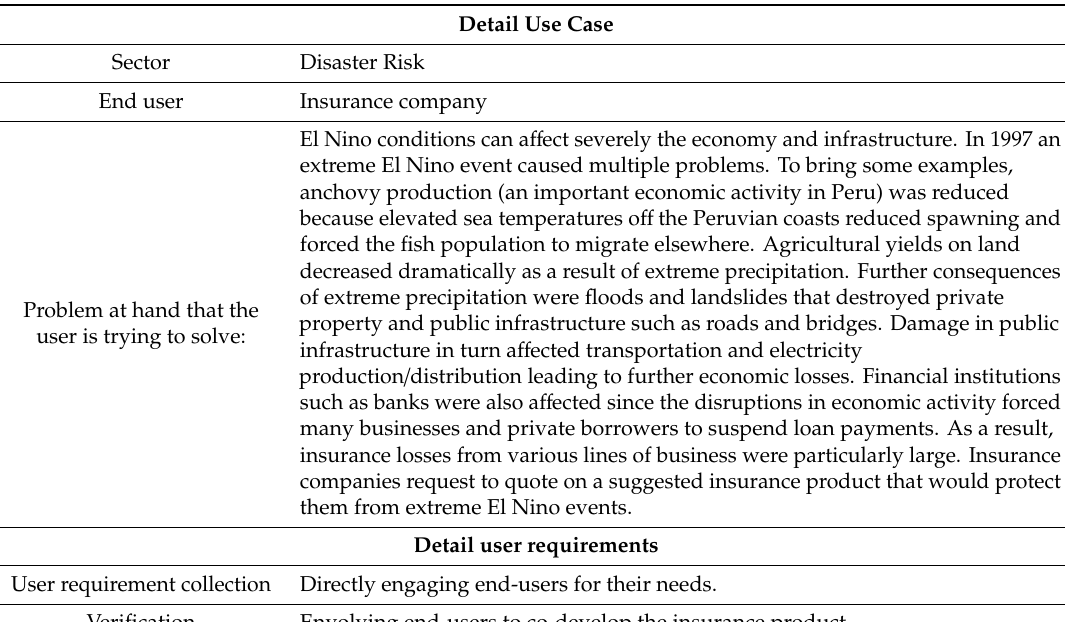
Table 4. An example of detailing use case and user requirements for an insurance company.